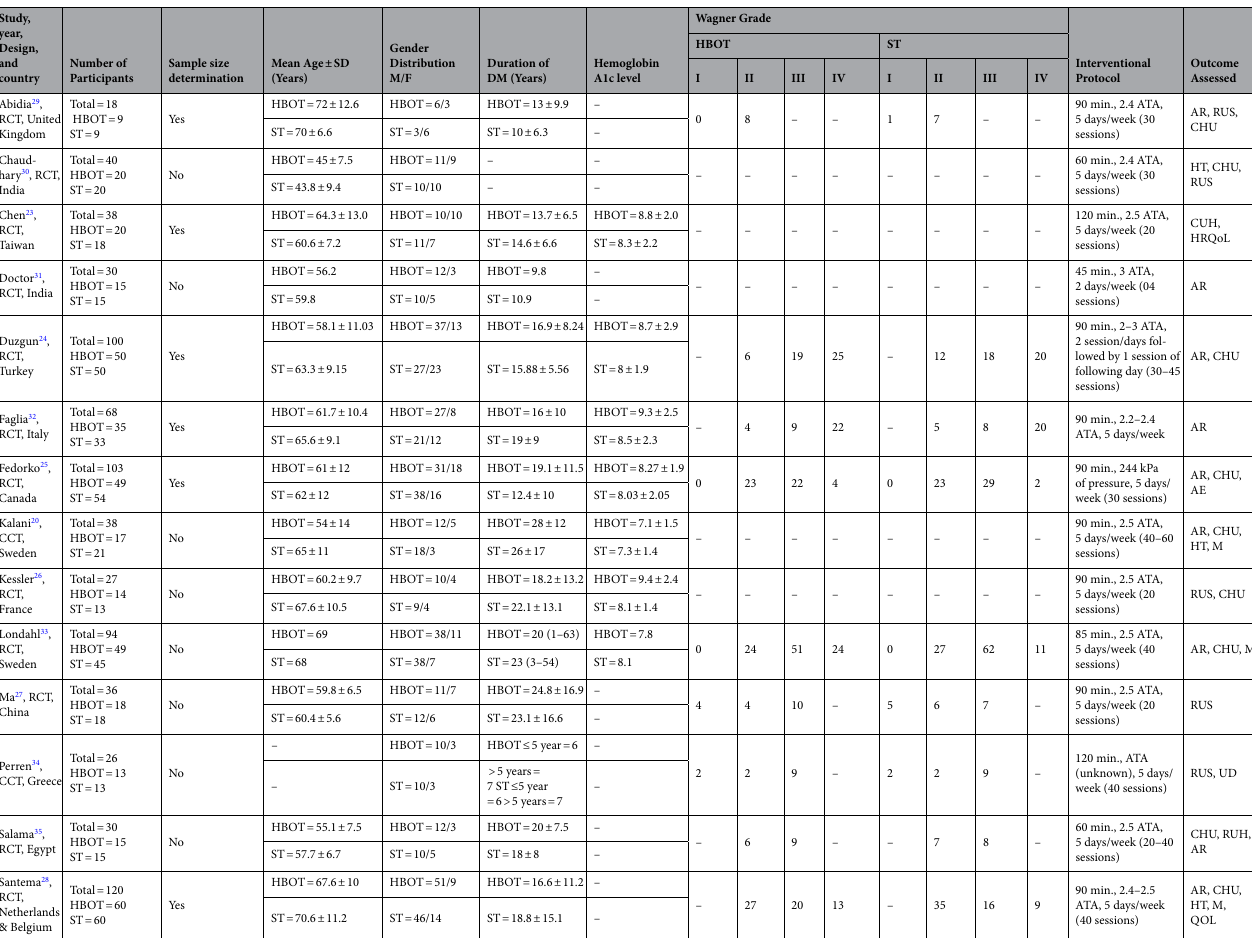
Table 1. Characteristics of studies included in systematic review and meta-analysis. AE adverse event, AR amputation rate, CCT controlled clinical trial, CHU complete healed ulcer, DM -diabetes mellitus, HBOT hyperbaric oxygen therapy, QOL quality of life, HRQoL Health Related Quality of Life, HT healing time, M mortality, RCT randomized controlled trial, RUS reduction in ulcer size, SD standard deviation, ST standard treatment, UD ulcer